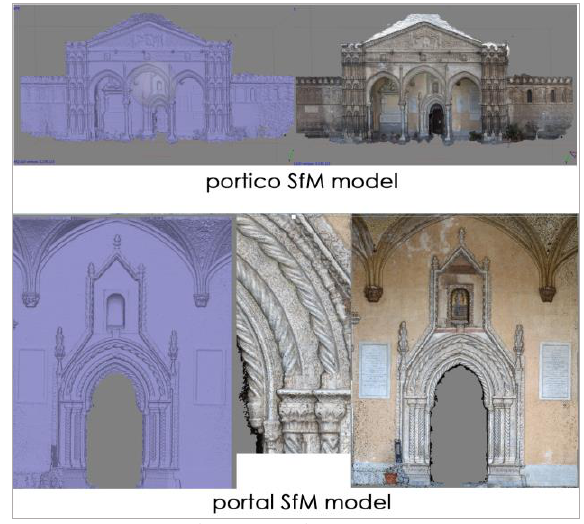
Figure 18. SfM model of the Portico and Portal